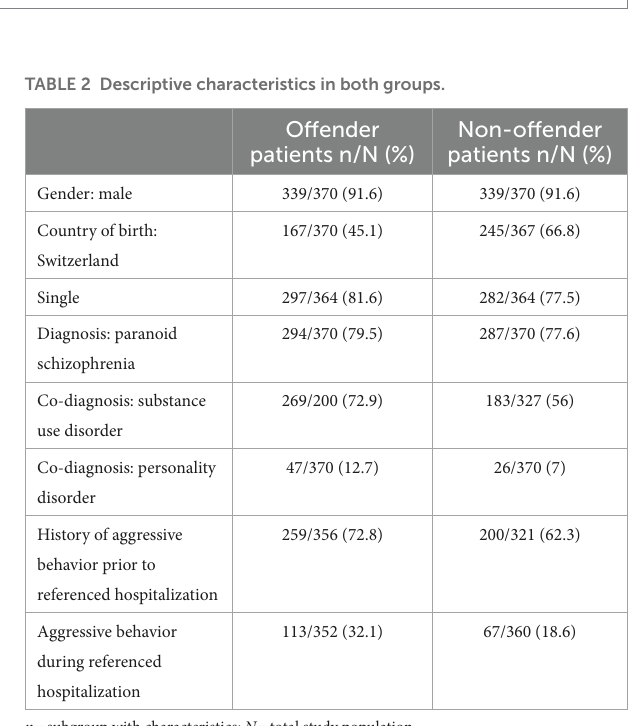
FIGURE 2 Model building and testing on validation set.